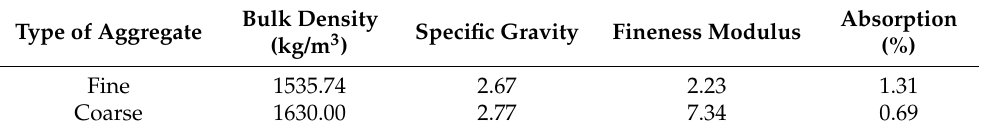
Table 2. Physical characteristics of the aggregates.